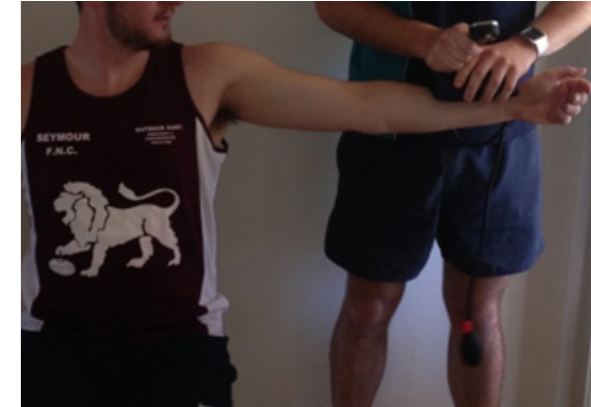
Figure 1 - Measurement procedure for shoulder flexion strength.